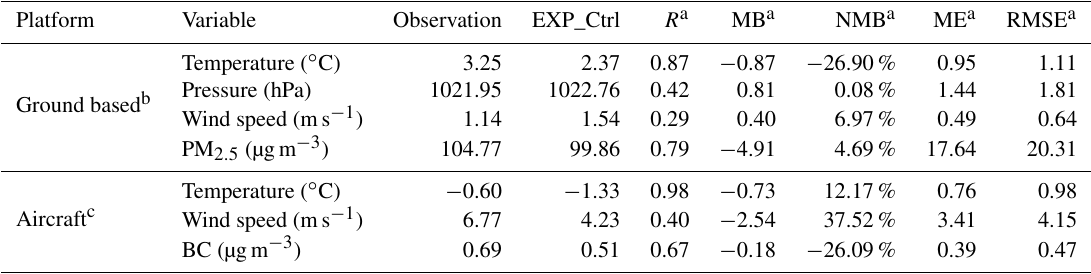
Table 3. Statistical evaluations of the WRF-Chem performance between in situ observations and EXP_Ctrl. Platform Variable Observation EXP_Ctrl